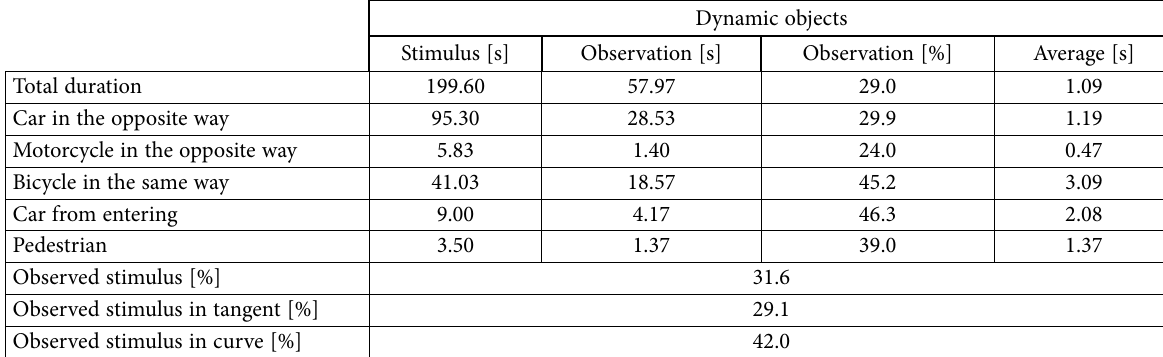
Table 4. Characteristics of the driver’s glance about the dynamic objects during the travel